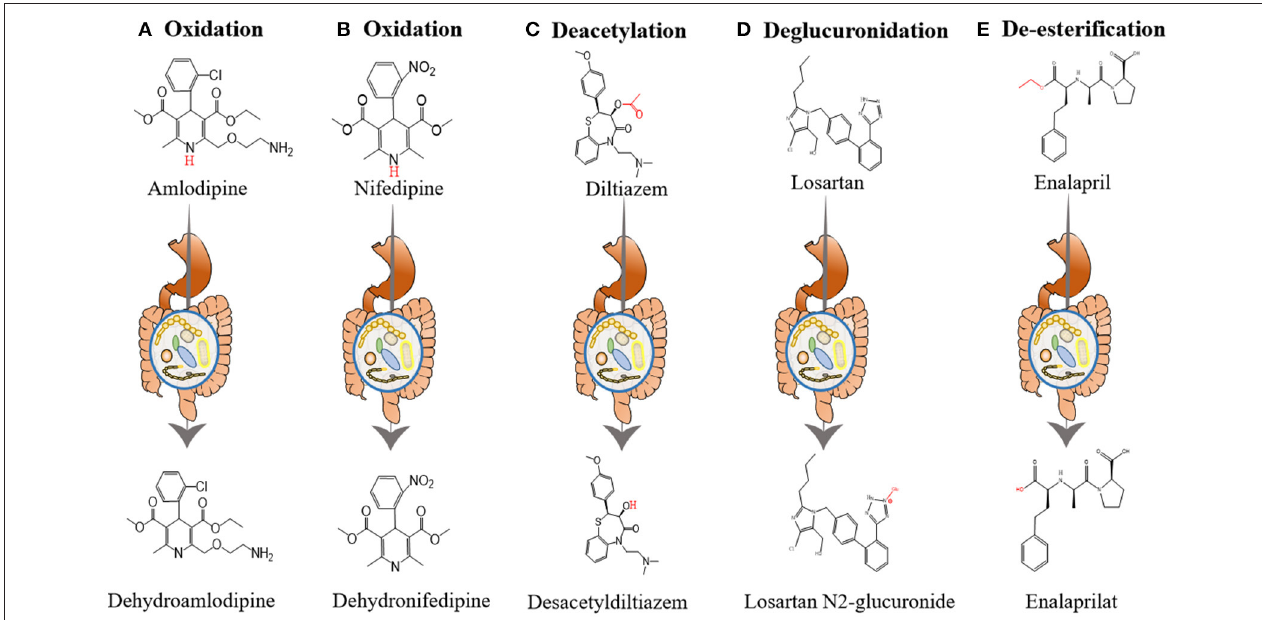
FIGURE 2 | The influence of gut microbiome on the metabolism of antihypertensive drugs. (A) Oxidation of amlodipine. Amlodipine is converted into dehydroamlodipine through the oxidation reaction of gut microbiome. (B) Oxidation of nifedipine. Biotransformation of nifedipine produces dehydronifedipine through gut microbiome. (C) Deacetylation of diltiazem. Diltiazem is converted into desacetyldiltiazem through the action of gut microbiome. (D) Deglucuronidation of losartan. Losartan is converted into losartan N2-glucuronide through the action of gut microbiome. (E) De-esterification of enalapril. Enalapril is converted into enalaprilat through the de-esterification reaction of gut